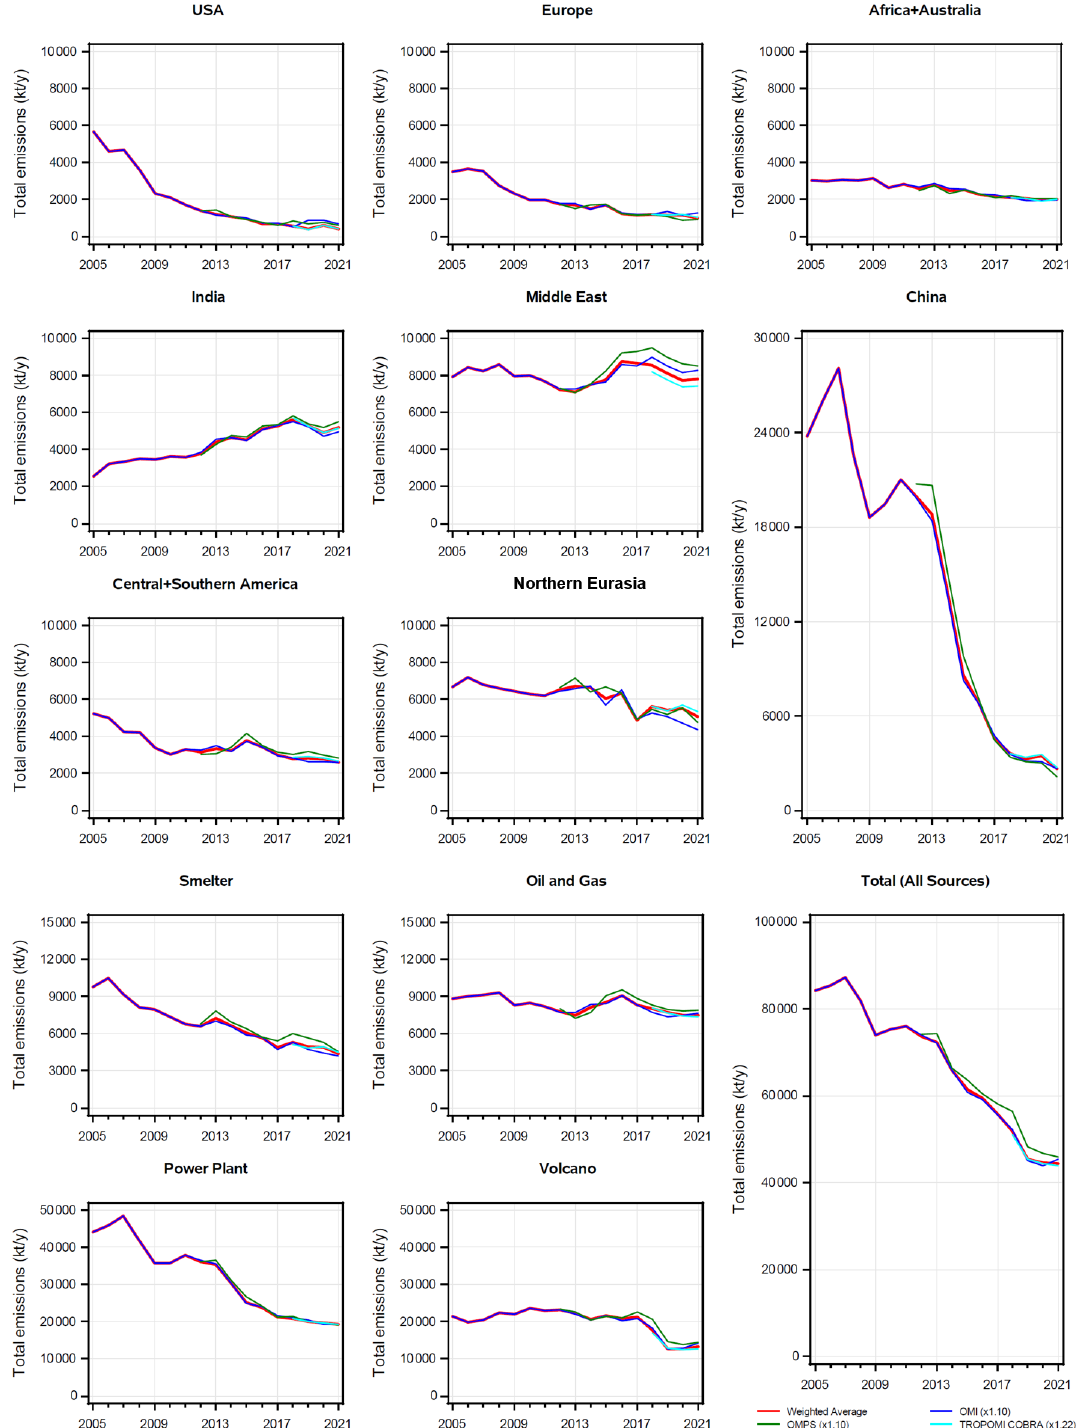
Figure 5. Annual SO 2 emissions from four satellite datasets: version 2 catalogue OMI VCD data (blue), version 2 catalogue OMPS data (green), version 2 catalogue TROPOMI COBRA data (cyan), and the weighted average (red). The data are grouped by region (eight top panels), by emission source type (bottom four panels), and the bottom right panel shows total emissions from all sources. TROPOMI-based estimates were increased by 22% and OMI and OMPS data were increased by 10% as discussed in the text. The weighted average is based on OMI data only in 2005–2011, on OMI and OMPS data in 2012–2017, and on data from all three instruments in 2018–2021.